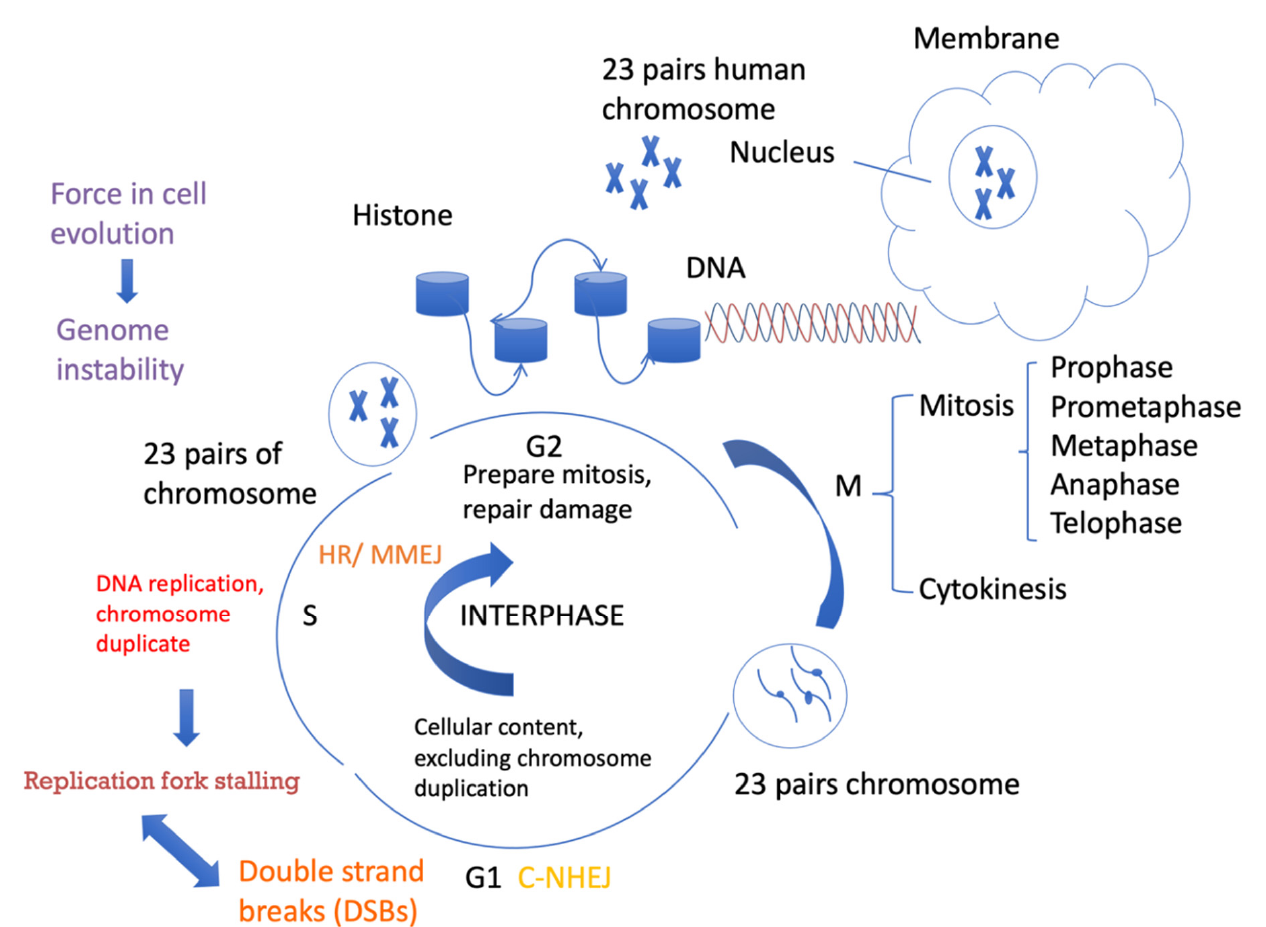
Figure 1. Cell cycle progression and DSB repair. Cells spend a long time in interphase and a very short amount of time in mitosis. In the G1 phase, cellular contents, excluding chromosomes, are duplicated. In the S phase, DNA is replicated. In the G2 phase, cells need to be prepared for mitosis. Different DSB repair pathways favor different phases of the cell cycle. C-NHEJ can take place anytime during the cell cycle, but it is more active in G1. HR requires sister chromatids as templates for repair and mainly occurs in the S/G2 phases. MMEJ activity also increases in the S phase and can also occur in the G1 phase.